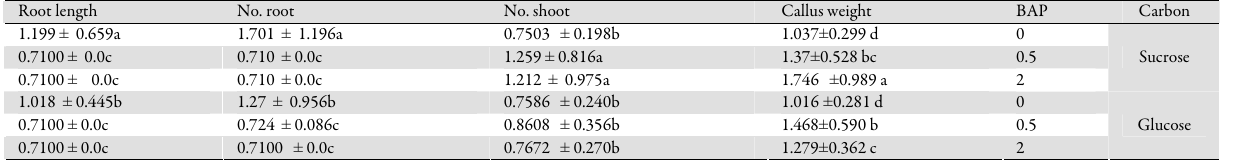
Table 6. The interaction between NAA and explants on callus, shoot and root induction of A . annua on MS medium No. root